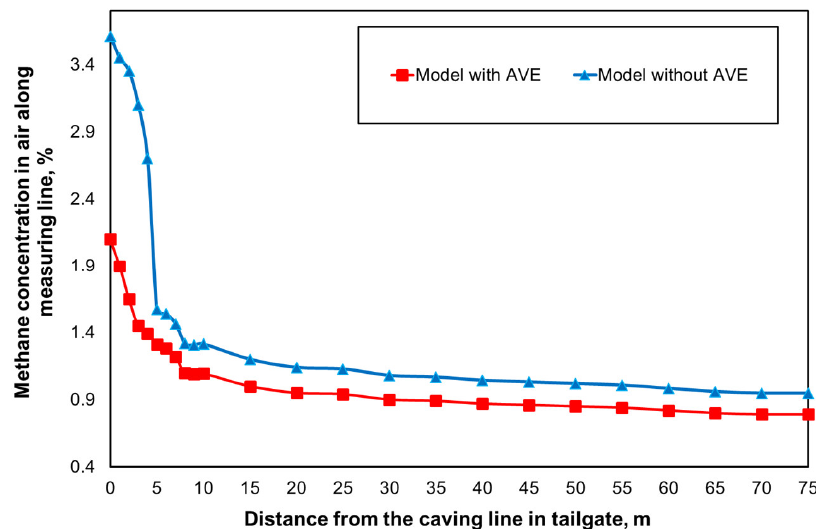
Figure 17. The values of methane concentrations in the points located on the assumed measurement line for the systems with and without AVE.